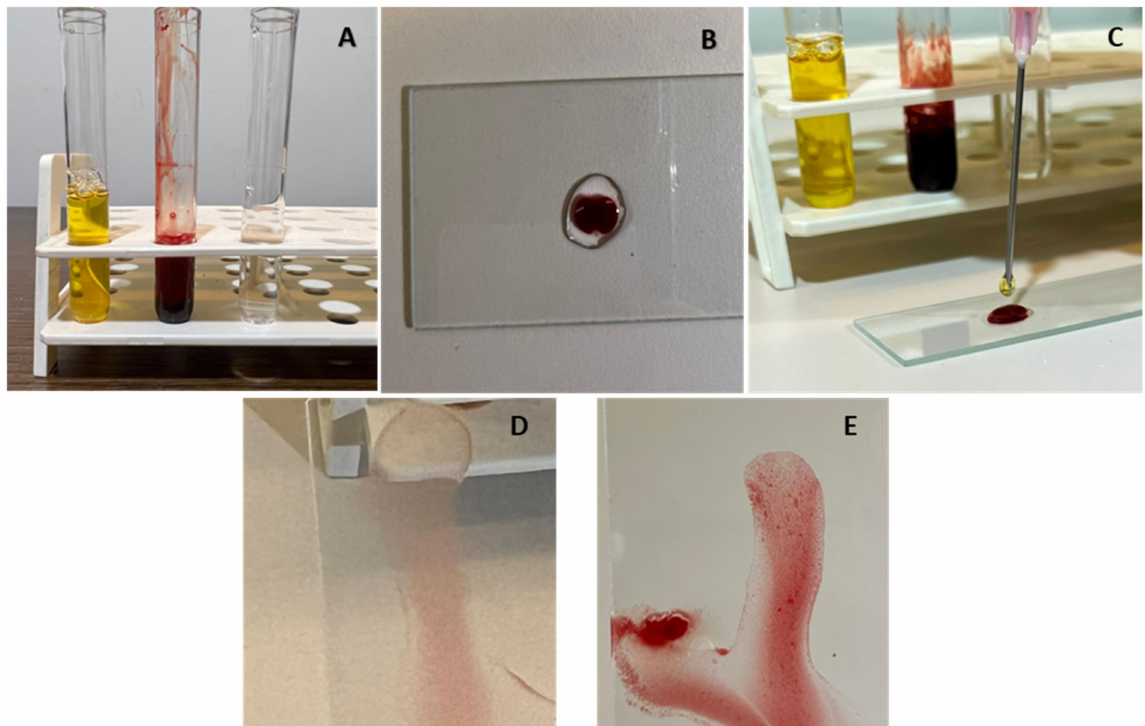
Figure 1. Crude slide agglutination test for blood type compatibility. Major cross match